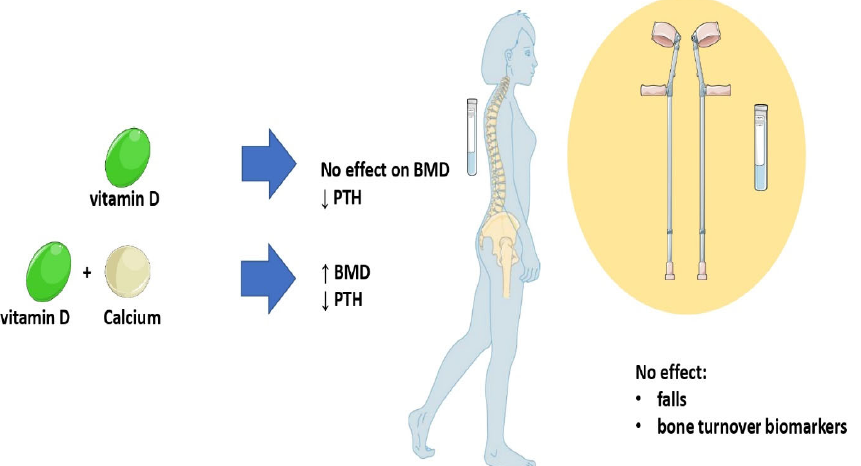
Figure 1. Summary of the main conclusions. Part of the figure were drawn by using pictures from